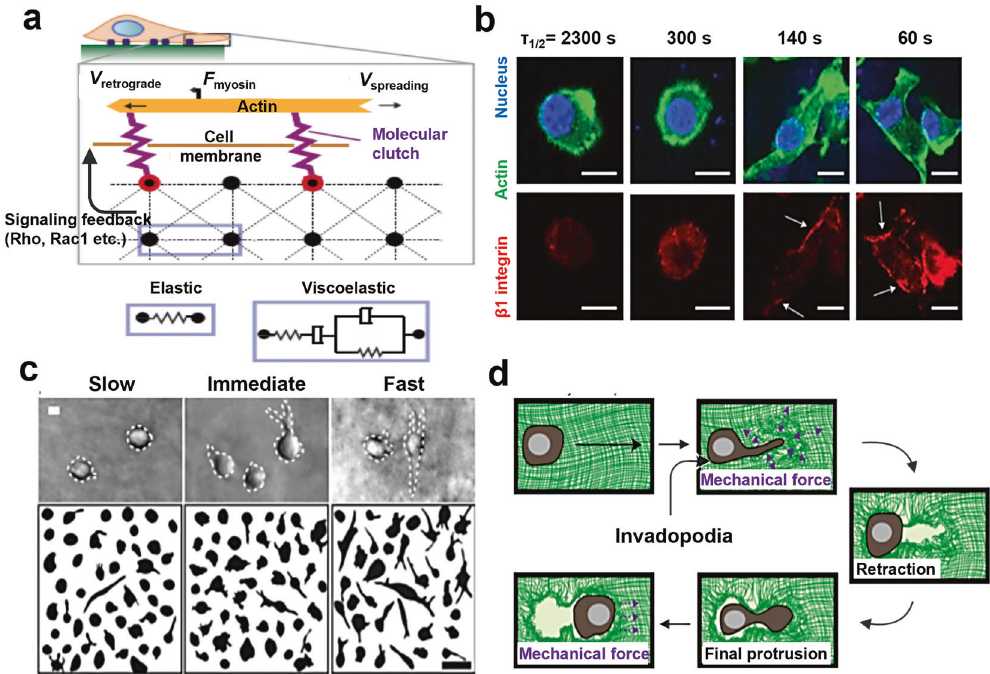
Fig. 5 Clari fi cations and evidences on how hydrogel viscoelasticity regulated cell biology. a Schematic image of the interaction between cells and elastic/viscoelastic hydrogel via activating Rho and Rac1 signaling pathways. Reproduced with permission. 14 Copyright 2015, Springer nature. b A case depicting how hydrogel with fast stress relaxation promoted stem cell spreading and β 1 expression and led to integrin clustering. Reproduced with permission. 27 Copyright 2015, Springer nature. c Protease-independent invasion way in cancer cells when cultured in viscoelastic hydrogels with slow, immediate, and fast relaxation rates, and d schematic on the migration mode of cancer cells via progressively widening surrounding hydrogel matrix with invadopodia rather than proteases. Reproduced with permission. 240 Copyright 2018, Springer